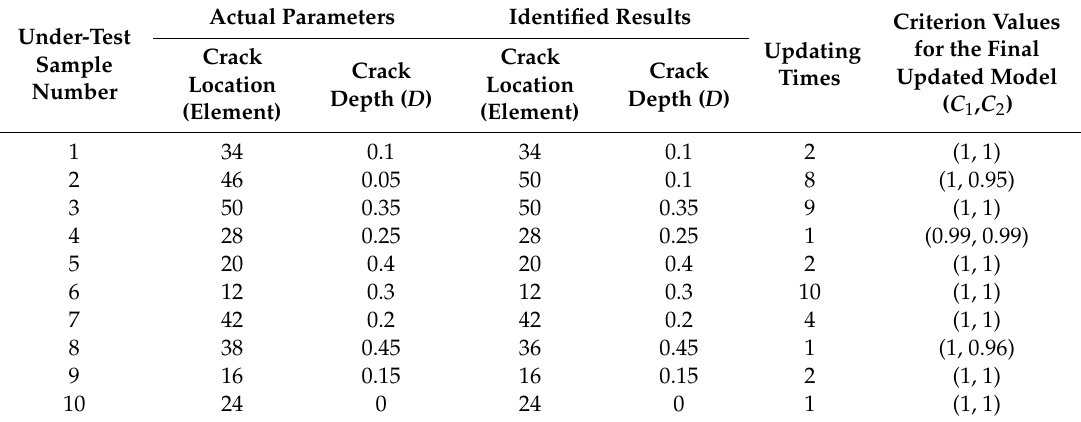
Figure 10. Update process of the under-test samples with 5% noise. ( a ) Identification process for all samples; ( b ) identification process and corresponding value of identified feature for sample 6. Table 4. Crack identification results of the under-test samples with 5% noise.